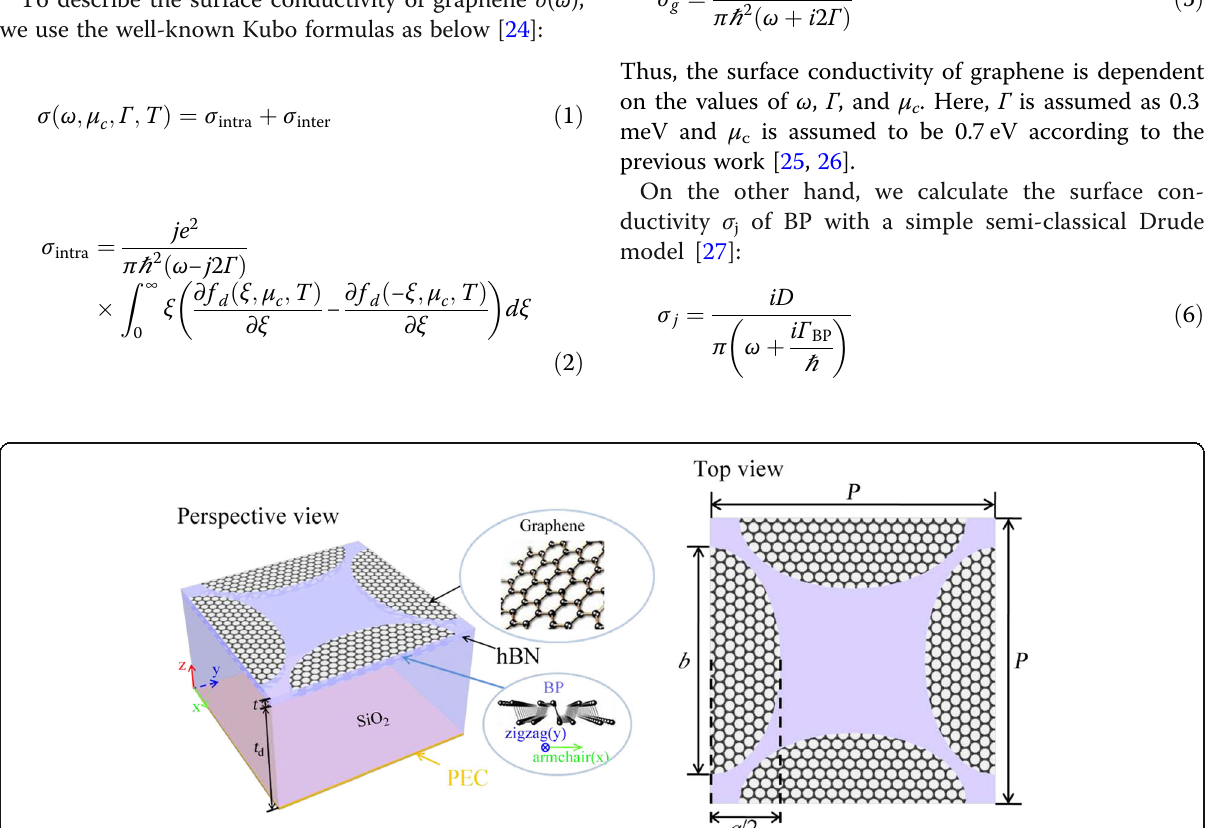
Fig. 1 A unit cell of the proposed absorber based on elliptical graphene-BP pairs. t d and t are the thicknesses of the dielectric and insulator layer, respectively. a and b are the short axis and long axis of the ellipse. P is the periodic side length of the square unit